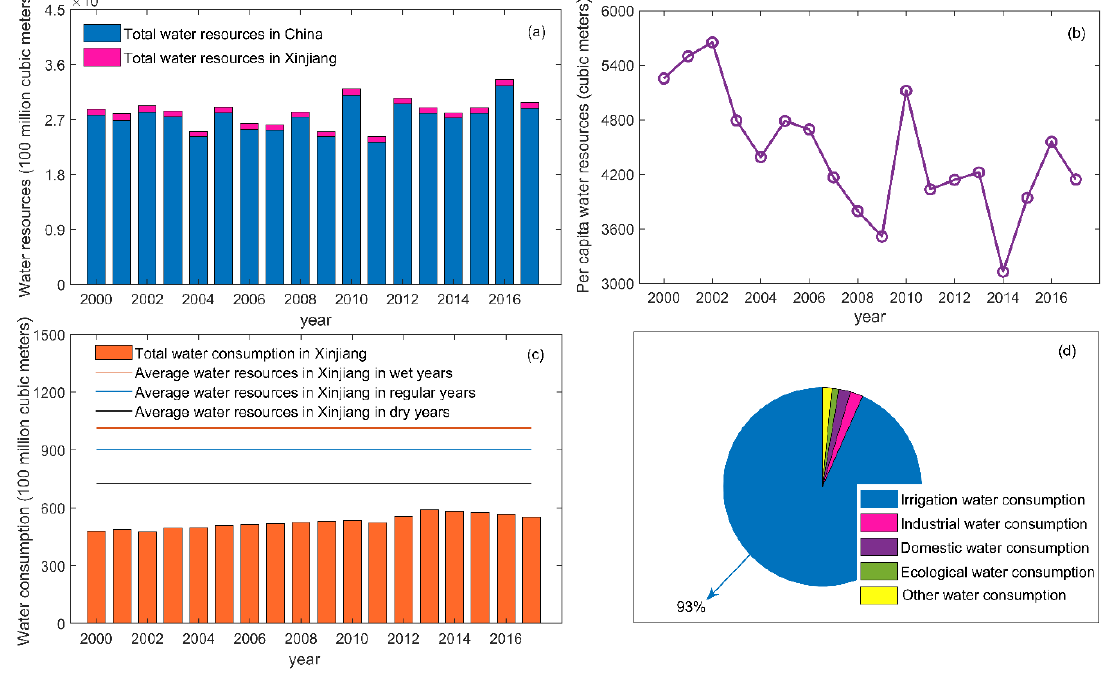
Figure 3. Development and utilization of water resources in Xinjiang. ( a ) is the comparison between water resources in Xinjiang and in China; ( b ) is the changes in per capita water resources; ( c ) is the changes in total water resources and water consumption; ( d ) is the allocation of water consumption.